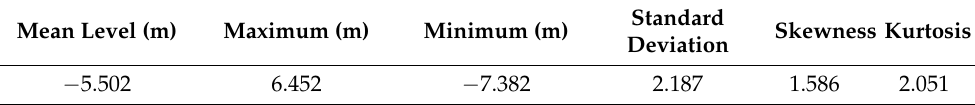
Table 1. The descriptive statistics of the forebay water level data.